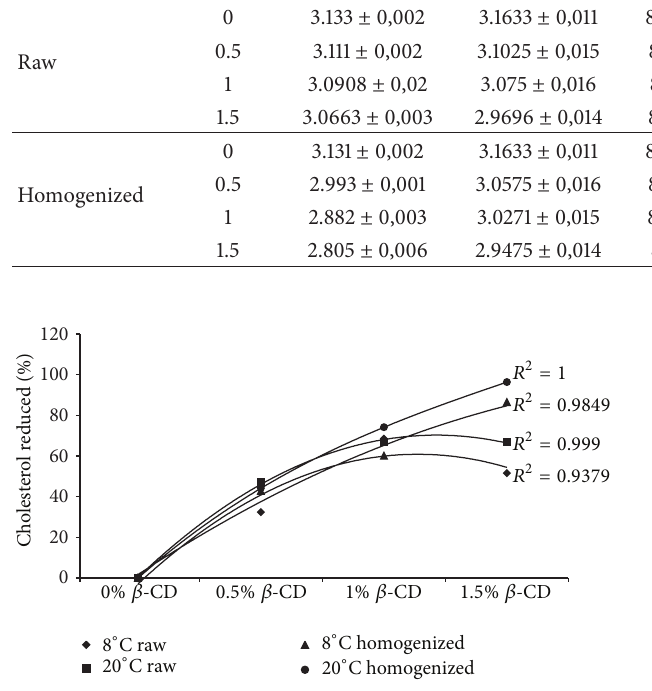
Figure 3: The cholesterol reduction in both raw and homogenized milks using various concentrations of 𝛽 -CD for both temperature conditions.